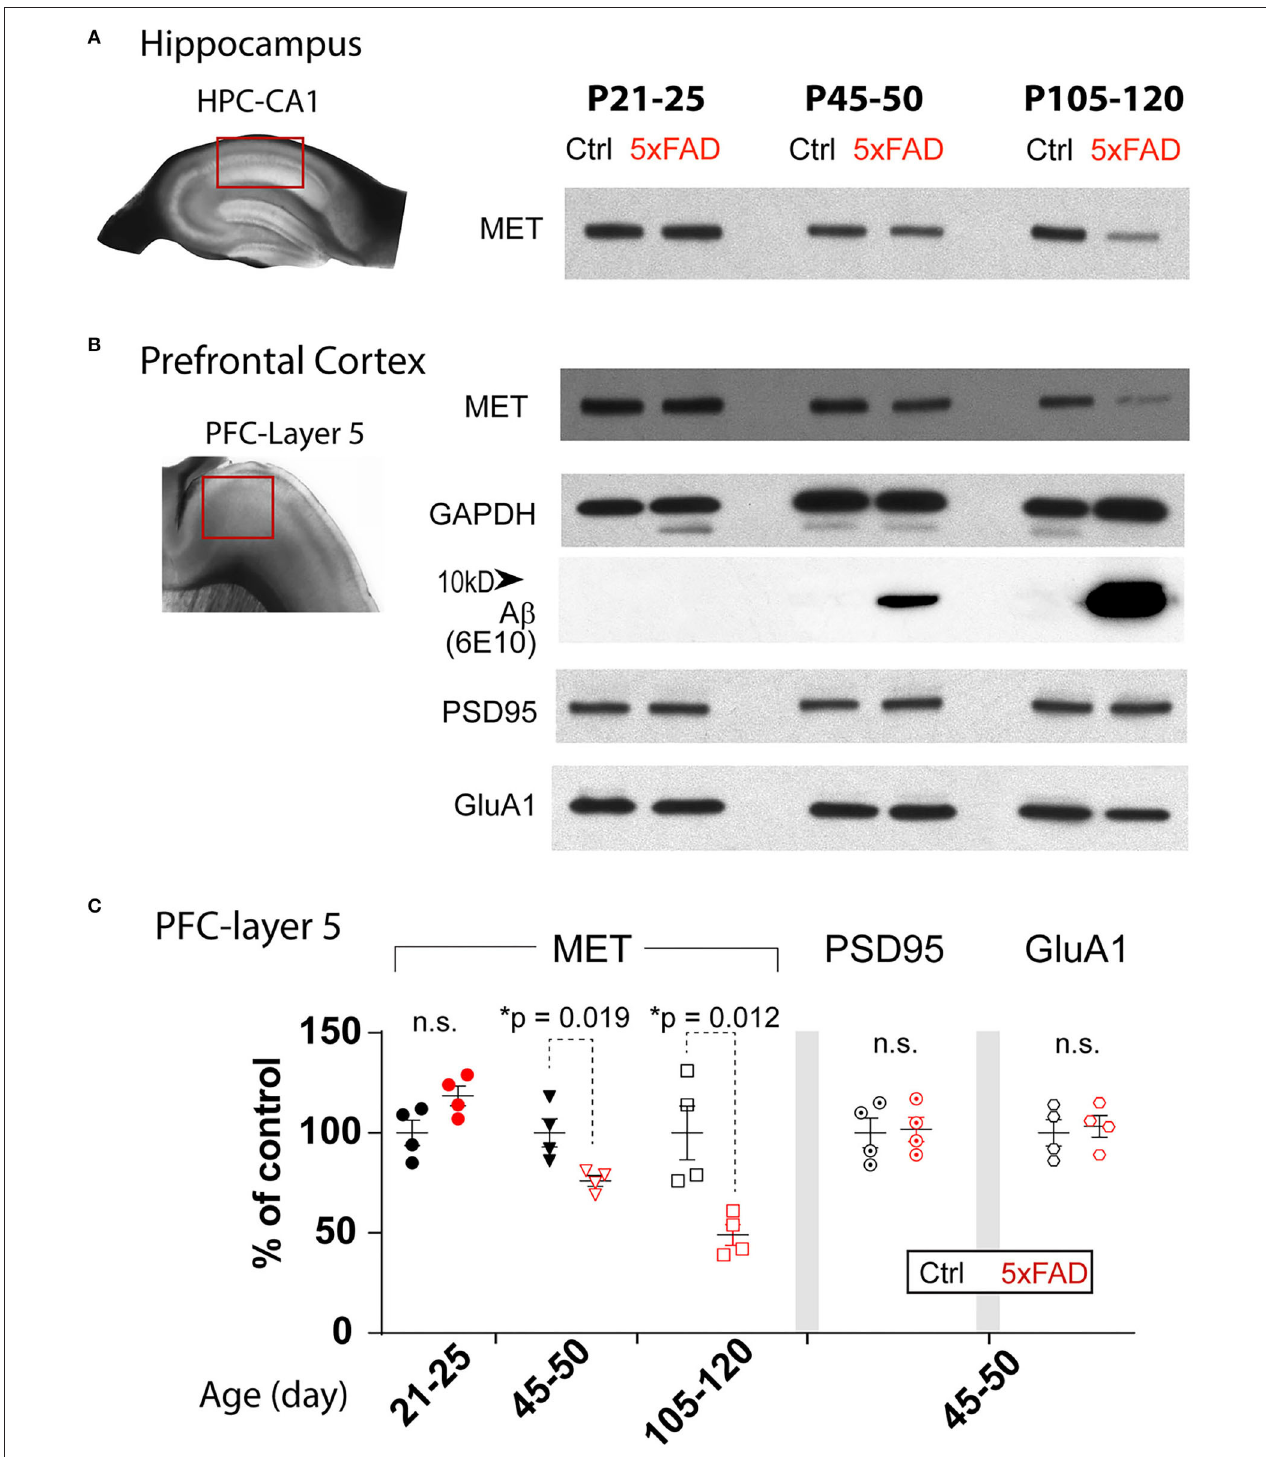
FIGURE 1 | Age-dependent decrease of MET protein in PFC and HPC in 5XFAD mice. (A) Western blot showing MET protein levels from control and 5XFAD hippocampus CA1 regions at three ages: P21-25, P45-50, and P105-120. (B) MET and other synaptic protein levels in micro-dissected L5 PFC tissues. The same age-dependent reduction of MET protein is observed (signals normalized to GAPDH loading control). Abrupt increase in A β levels was seen in P45-50 and older tissues. Other synaptic proteins, including PSD95 and GluA1, were not different between control and 5XFAD PFC L5 tissues. (C) Quantification of western blot results in PFC tissues. MET protein shows a significant reduction at P45-50 (* p = 0.019) and P105-120 (* p = 0.012). No difference in the levels of PSD95 and GluA1 was seen.